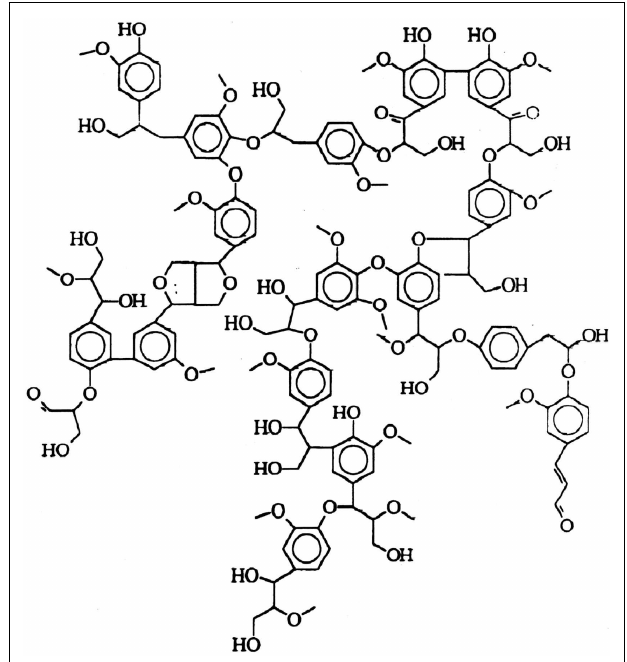
FIGURE 1 | Structure of lignin, composed by phenylpropane units, Adler (1997).